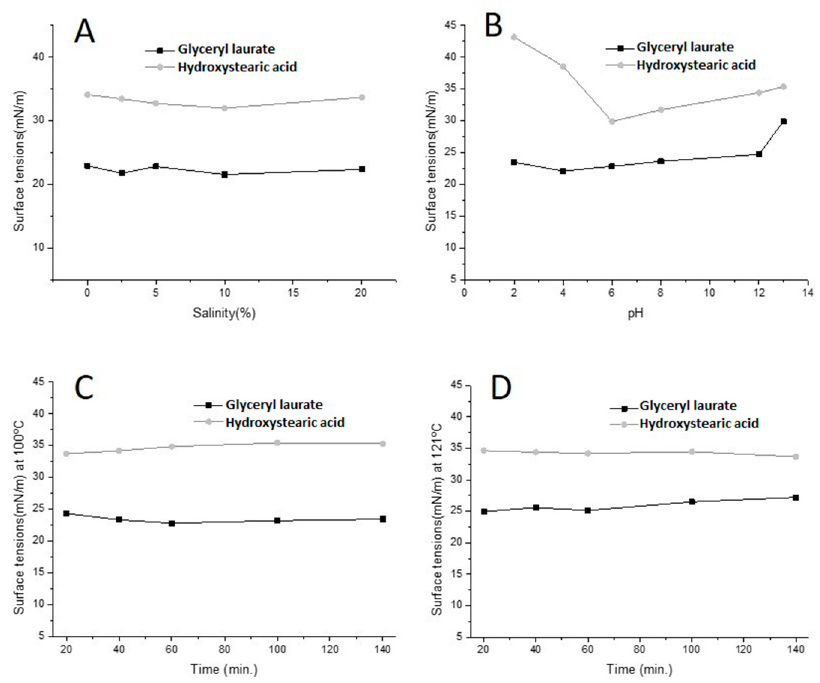
Figure 2. Influence of salt concentration ( A ), pH ( B ) and temperature versus time ( C , D ) on surface activity of the glyceryl laurate and hydroxylated oleic acid.